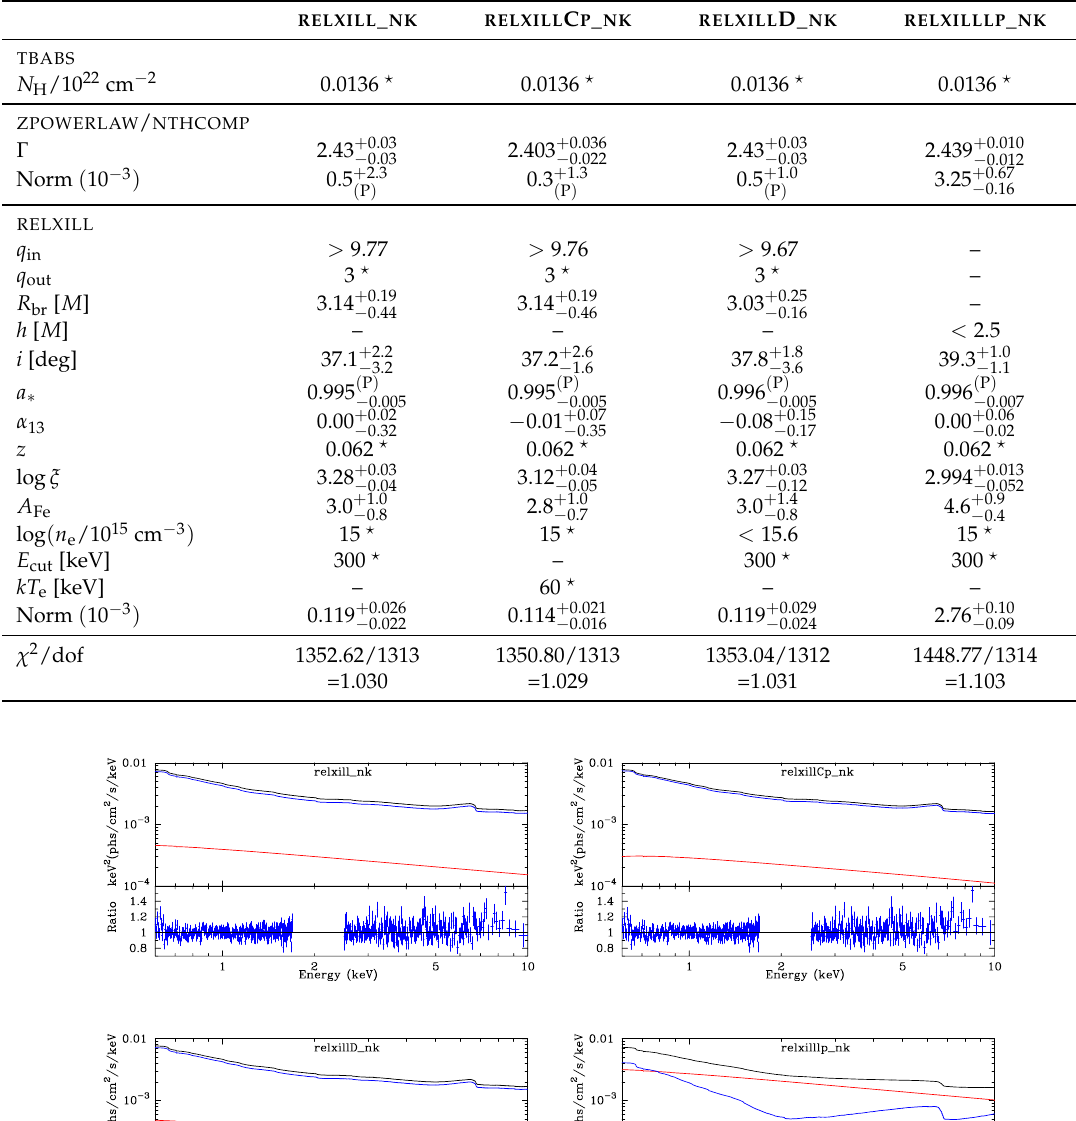
Table A1. Summary of the best-fit values for the supermassive black hole in Ton S180. In TBABS , N H is the column density. In ZPOWERLAW / NTHCOMP , Γ is the photon index. In RELXILL , q in is the inner emissivity index, q out is the outer emissivity index, R br is the breaking radius, h is the height of the corona in the lamppost model, i is the inclination angle of the disk with respect to the line of sight of the observer, a ∗ is the spin parameter, α 13 is the deformation parameter, z is the cosmological redshift, ξ is the ionization parameter, A Fe is the iron abundance (in units of the Solar iron abundance), n e is the disk electron density, E cut is the high-energy cut-off of the power-law component, and kT e is the electron temperature of the corona. (cid:63) indicates that the parameter is frozen to that value in the fit.